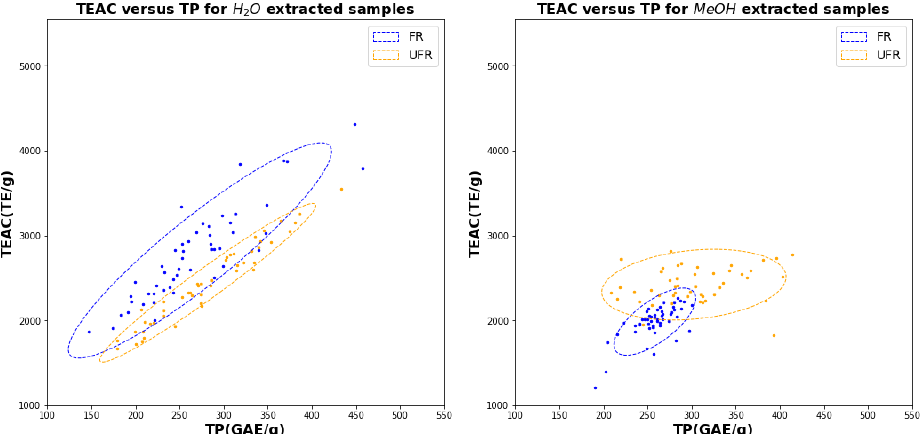
Figure 7. Scatter diagram for TP versus TEAC using water (left) and methanol for 51 FR samples (blue) and 47 UFR samples (orange).